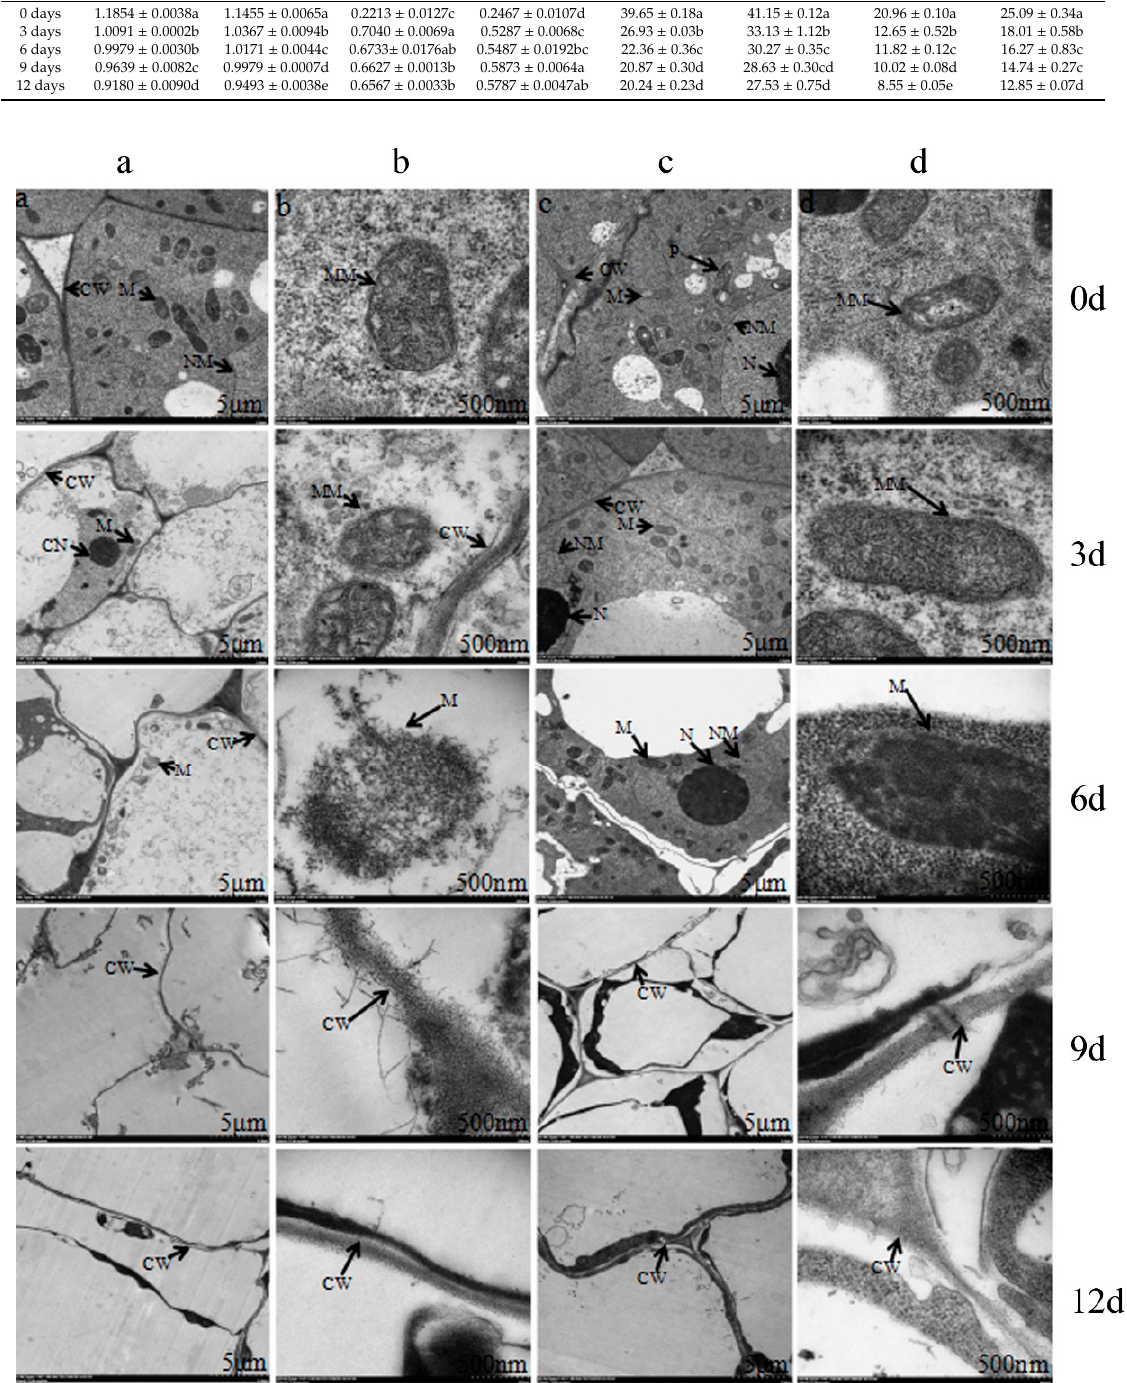
Figure 3. The effects of Ca(NO 3 ) 2 stress on the ultrastructure of mitochondria in roots of cucumber plants. ( a , b ) CQ and ( c , d ) BM. CW, cell wall; CN, cell nucleus; N, nucleolus; NM, nuclear membrane; M, mitochondrion; MM, mitochondrial membrane; P, plastid. The scale bars for root cells and mitochondria are 5 µ m and 500 nm, respectively.